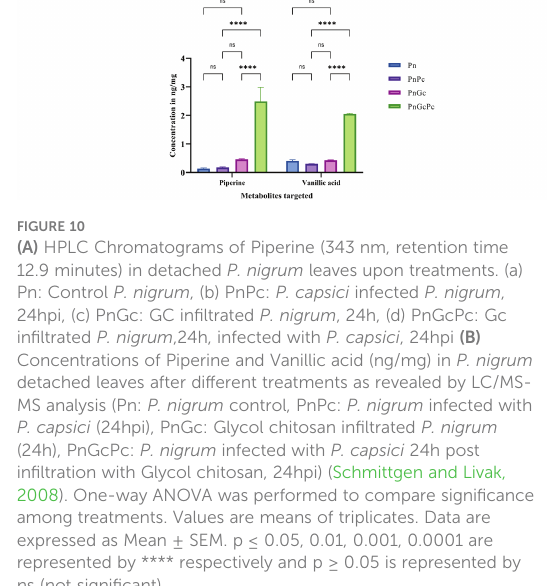
FIGURE 9 Gene Enrichment analysis using PANTHER (Mi et al., 2021) of signi fi cantly up-regulated genes upon GC treatment.